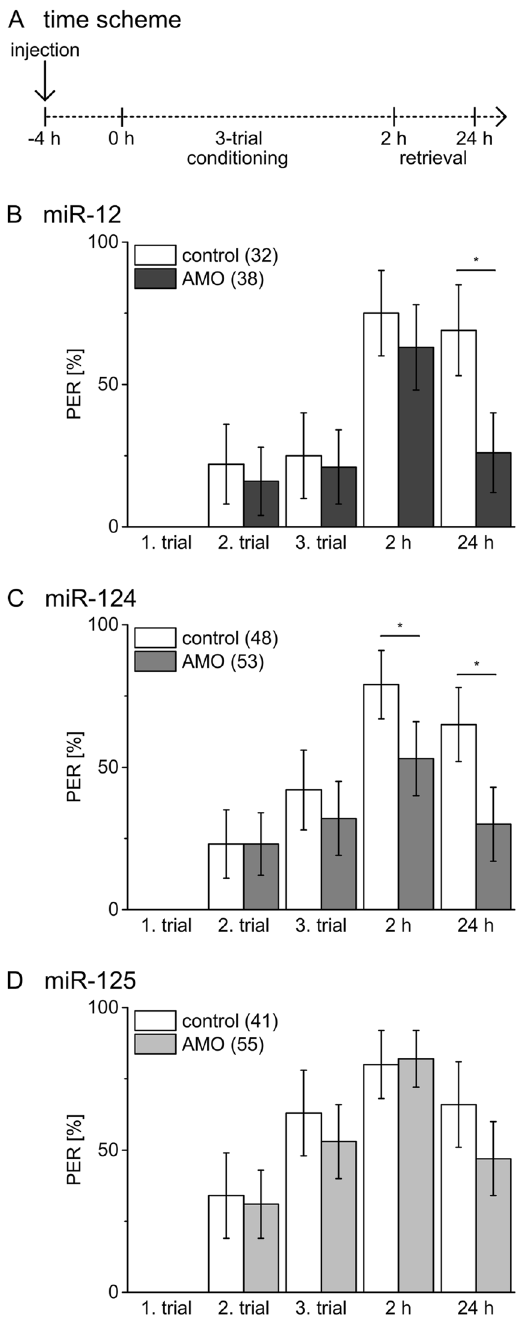
Figure 4. Inhibition of miRNAs before 3-trial conditioning affects early memory phases. ( A ) Four hours before 3-trial conditioning bees were injected with inhibitors (AMO) for miR-12 ( B ), miR-124 ( C ), miR- 125 ( D ) or PBS (control). Columns show the percentage of bees reacting with PER to odour presentation during conditioning and retrieval tests 2 h and 24 h after conditioning. The error bars indicate 95% binominal confidence interval and the numbers of tested animals per group are indicated in brackets. Asterisks show significant differences between groups (Chi-square/Fisher exact test (two-tailed) p < 0.05 details in